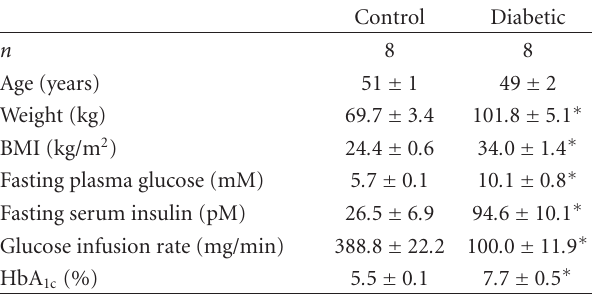
Table 1: In vivo characteristics.